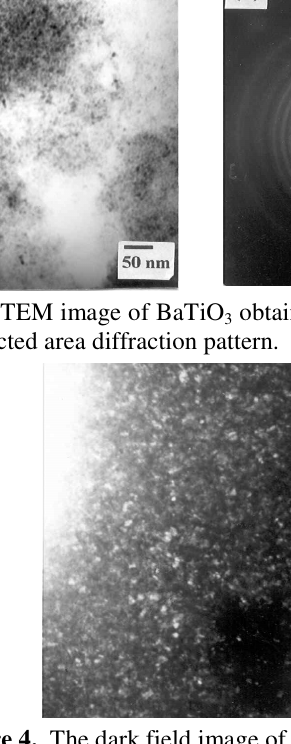
Figure 4. The dark field image of BaTiO